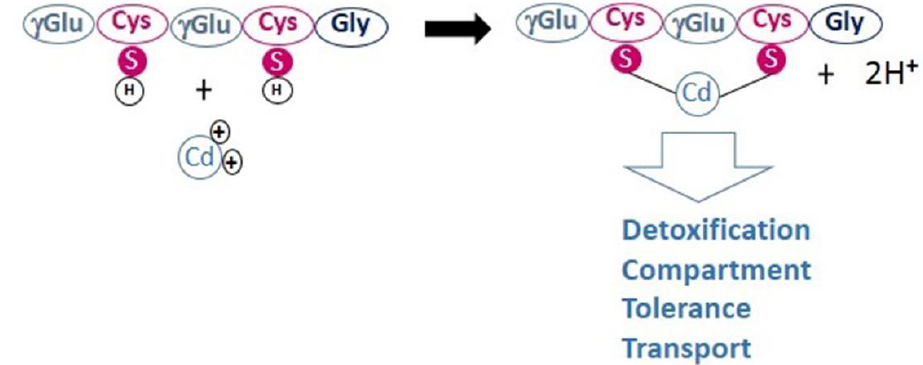
Figure 1. Example of phytochelatin – metal complexes for divalent cations. Figure inspired from that published by Dennis et al., 2019 [31].